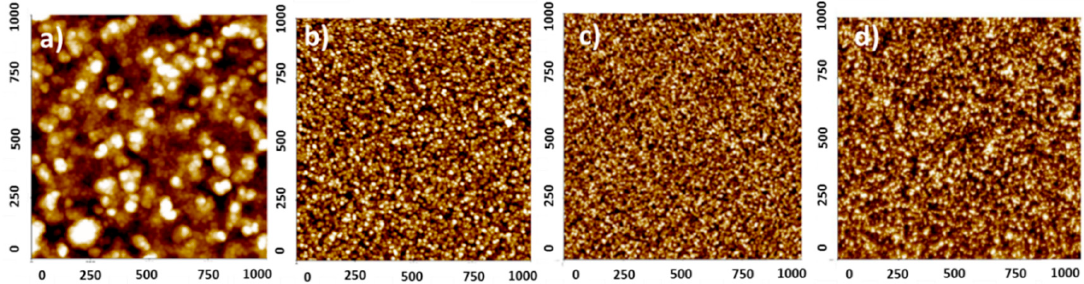
Figure 8. The AFM non-contact mode images of Ag doped CeO 2 in different CeO 2 :Ag ratios deposited at 200 °C: ( a ) 10:1; ( b ) 20:1; ( c ) 30:1; and ( d ) CeO 2 . The scales are in nm.